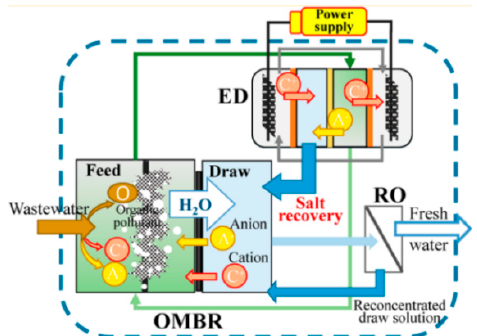
Figure 25. Wastewater treatment and water purification for zero liquid discharge (ZLD) by forward osmosis (FO) osmotic membrane bioreactor (OMBR)-ED (reprint with permission from Lu and He [307]. Copyright (2015) American Chemical Society). OMBR: osmotic membrane bioreactor; ED: electrodialysis; RO: reverse osmosis.